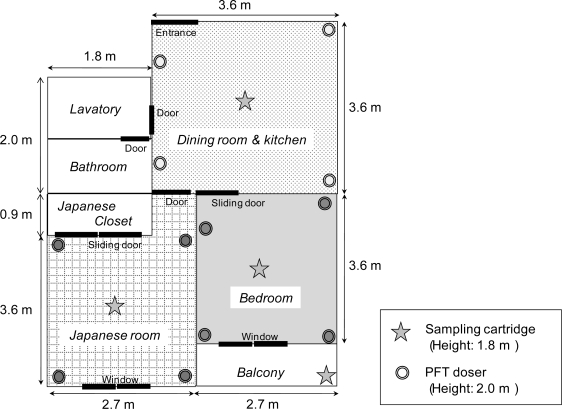
Layout of apartment in which measurements were taken, showing points where dosers and sampling cartridges were placed.